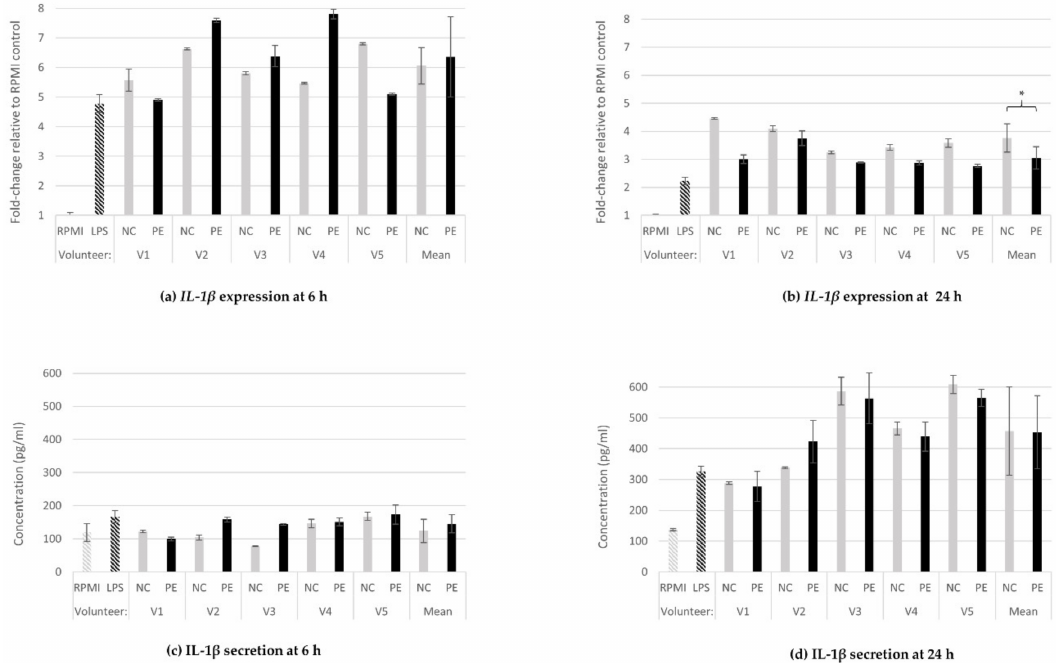
Figure 3. IL-1 β gene expression and protein release. Relative gene expression of IL-1 β at 6 h ( a ) and 24 h ( b ) of treatment of U937-derived macrophages with FSs, and IL-1 β concentration in supernatants of the same cells at 6 h ( c ) and 24 h ( d ). Gene expression is exhibited as fold-change of the value of the value in the untreated cells (RPMI) and relative towards GAPDH expression ( ∆∆ Ct) for all samples ( a , b ). The concentration of the cytokine is expressed in pg/mL of the cell culture supernatants ( c , d ). Data shown are the means and standard deviation (SD bars) from two technical